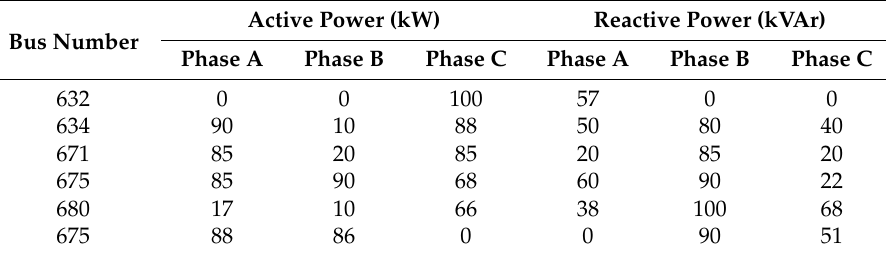
Table 1. Loads active and reactive power for average loading condition.